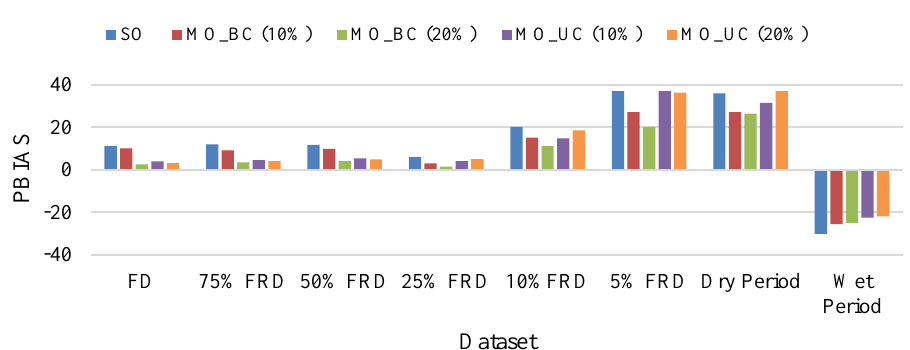
Figure 12. PBIAS values of different models using five datasets via two main calibration approaches (SO & 4 algorithms parameterization of MO-SB) for each dataset.